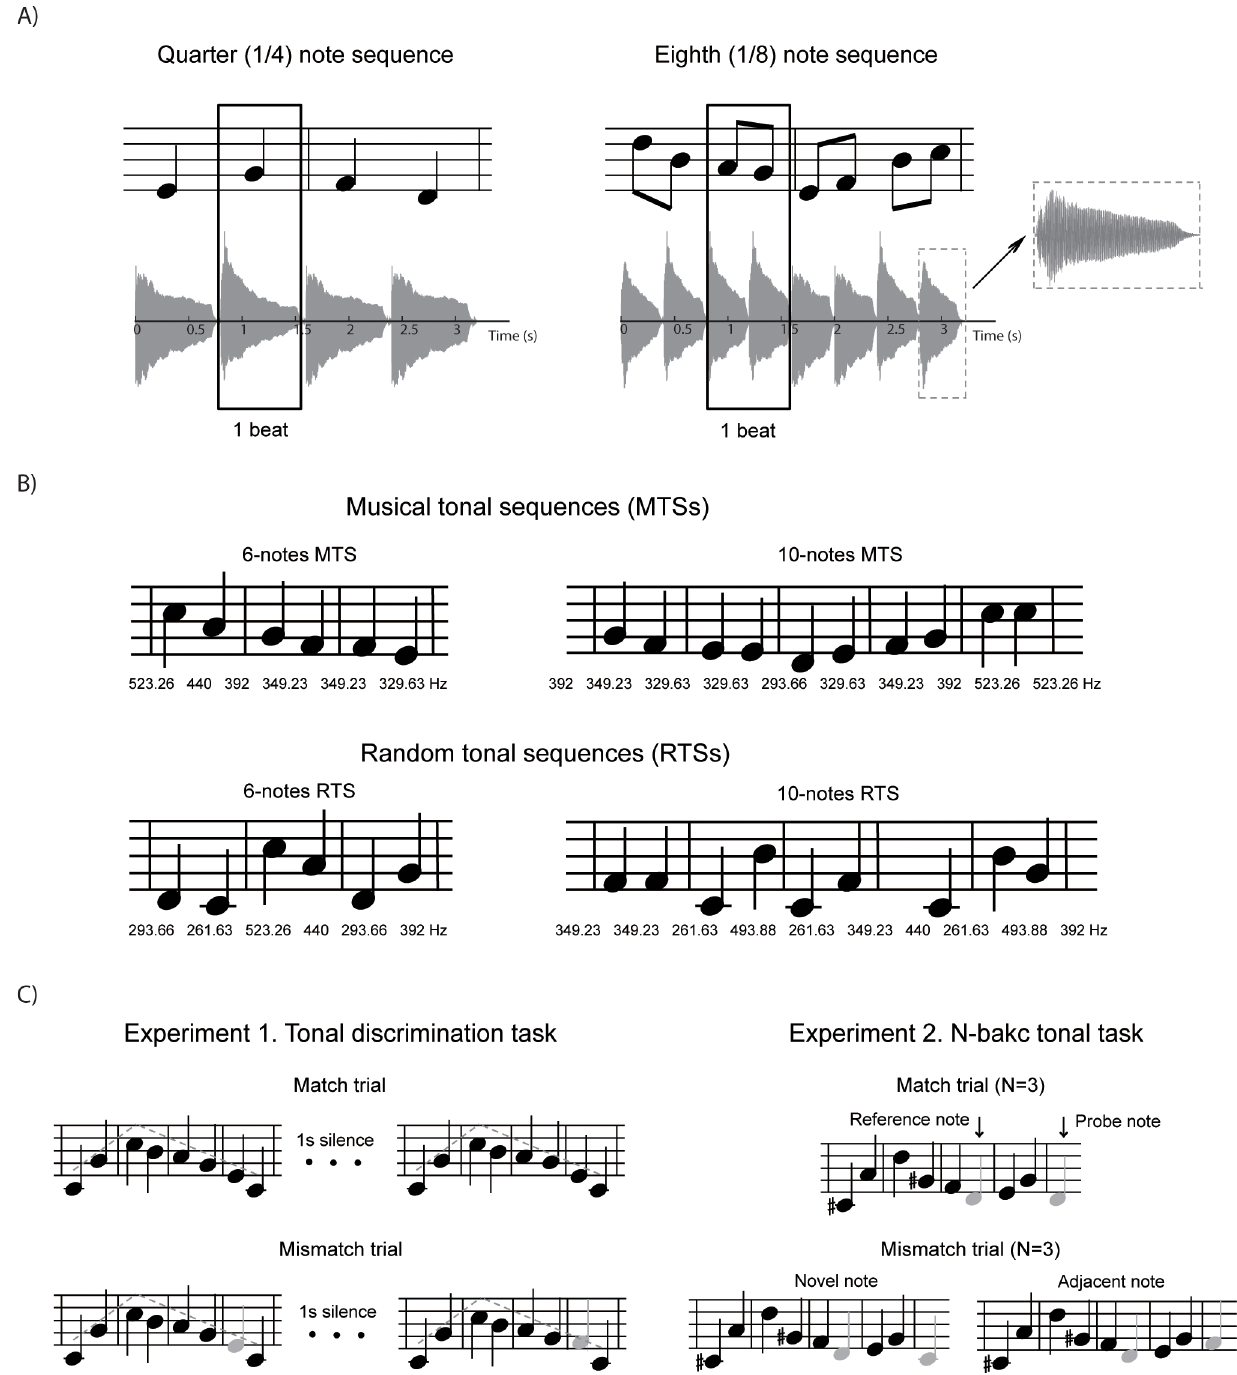
Fig 1. Examples of experimental stimuli and paradigm. ( A ) Top plots : Examples of a quarter (1/4) note sequence ( left )and an eighth (1/8) note sequence ( right ) with two measures. Bottom plots : amplitude profiles of the note sequences shown on the top. Each measure consists of two beats, in which one beat corresponds to one note for the quarter note sequence and two notes for the eighth note sequence. ( B ) Examples of musical tone sequences (MTSs, top plots ) and random tone sequences (RTSs, bottom plots ) with 6 notes ( left )or 10 notes ( right ). ( C ) Examples of testing sequence pairs. Left : Experiment 1, tonal discrimination task. The upper row is a match trial consisting of a pair of identical note sequences. The lower row is an example of mismatch trial, in which a note in the second sequence (gray note) is shifted up one semitone, but the pitch contour (dashed line) remains the same as the first sequence. The pitch shifts of mismatch trials happen in both directions, upwards or downwards. Right : Experiment 2, N-back tonal task. An example of N = 3 testing condition. The upper row is a match trial, in which the probe note (the last note) is the same as the reference note (the 3rd to the last note). The lower row